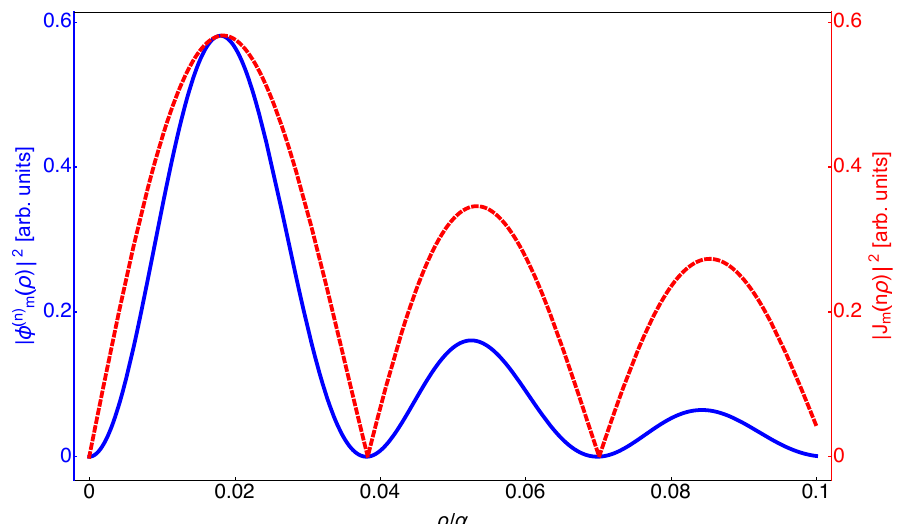
Figure 6. Comparison between the radial structure of a fundamental X-wave with n = 100 (blue, solid line) with that of the corresponding limiting form, i.e., a Bessel-X pulse with the same OAM value m = 1 (red, dashed line), in the plane ζ = 0. Notice that the scaling of the Bessel function is n ρ , which scales the distributions of zeros of the Bessel function to match that of the hypergeometric ( 100 ) function φ . The higher-order zeros cannot be easily visualized, due to the rapidly decaying 1 behavior of the hypergeometric function for large n . For this plot, ρ is measured in units of α for the X-wave, and w 0 = α has been assumed for the Bessel